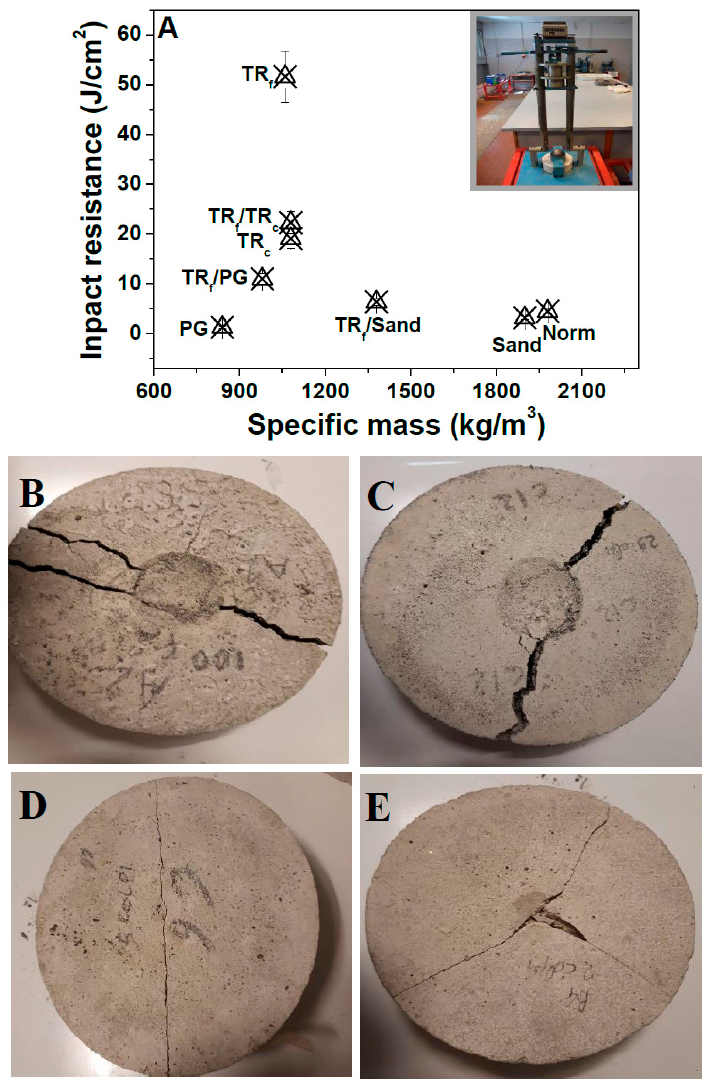
Figure 8. ( A ) Impact resistance of the cement mortars, ( B ) TR f (sample 3), ( C ) TR f /TR c (sample 7), ( D ) Norm (sample 1), ( E ) PG (sample